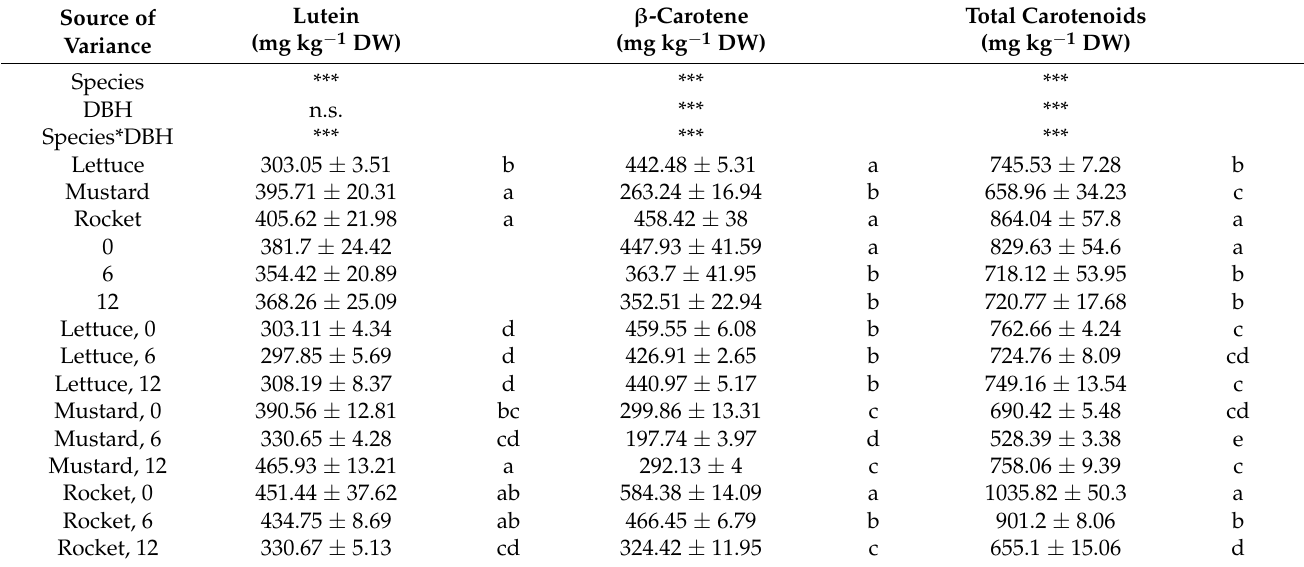
Table 4. Carotenoid content of three microgreen species (lettuce, mustard, and rocket) in response to nutrient